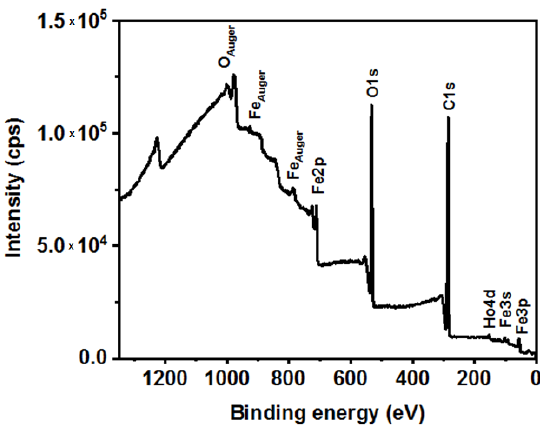
Figure 2. XPS overall spectrum of SPIONs doped with 1% holmium.